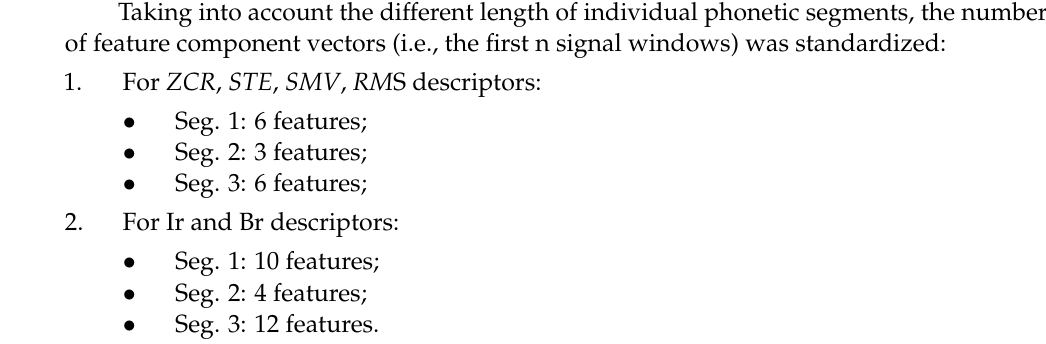
Figure 12. Br features distribution for the first phonetic segment of the word „barrel” (in Polish „beczka”).